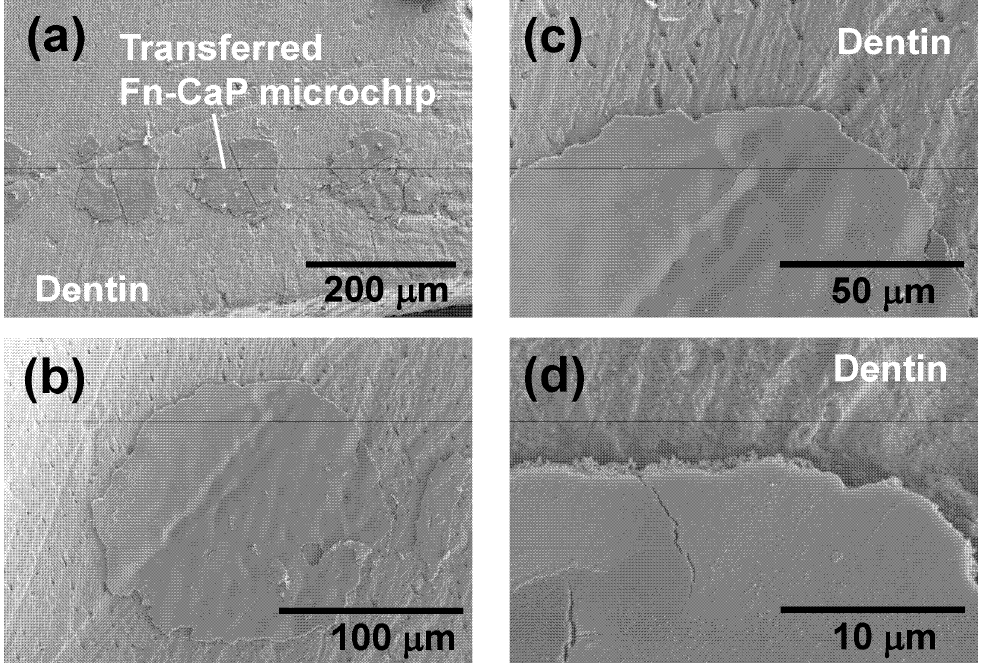
Figure 6. ( a – d ) SEM images of the Fn-CaP microchips transferred by LIFTOP on the dentin substrate.